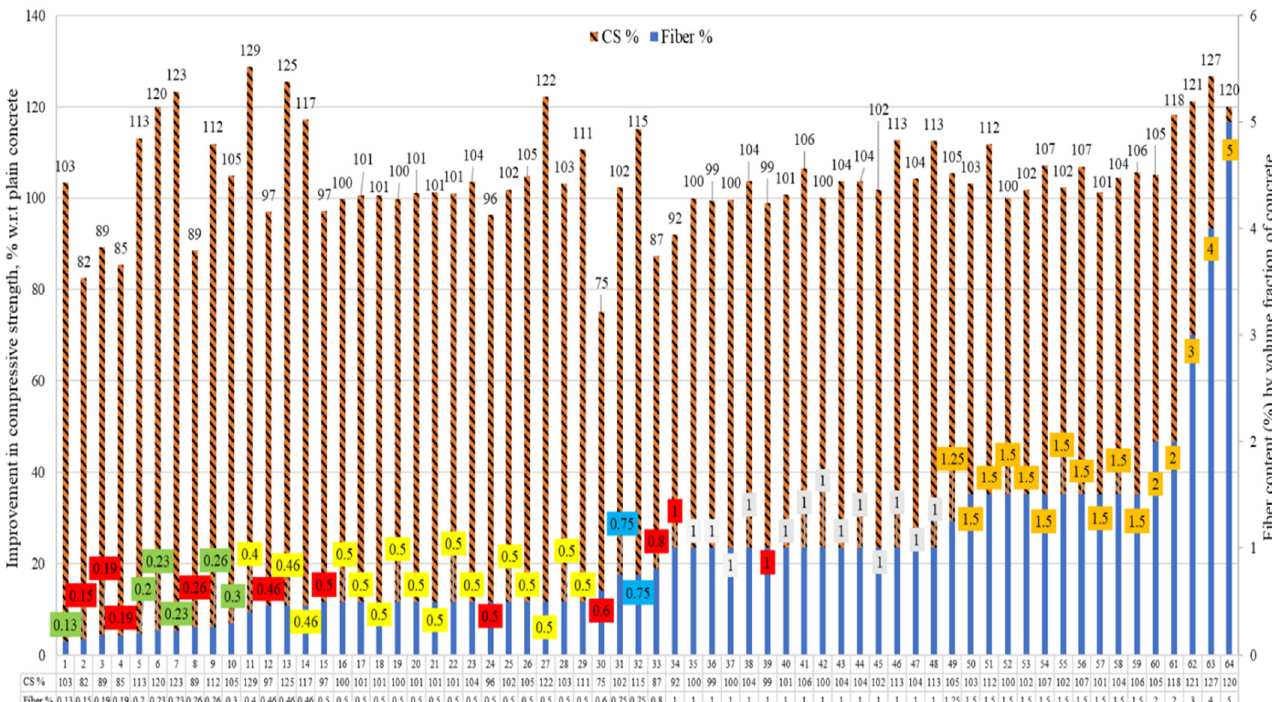
Figure 4. Percentage comparison of the compressive strengths of concrete containing RSF by volume fraction.